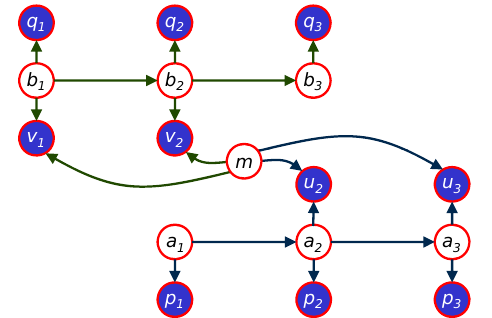
Figure 4. Bayes network for the situation in figure 3. a i , b i and m are the unknowns for the anchor points and surface elements, respectively, u i , v i are the observed distances from the measured points to their assigned surface element (equation type 1), and p i , q i are the observed exterior orientations (equation type